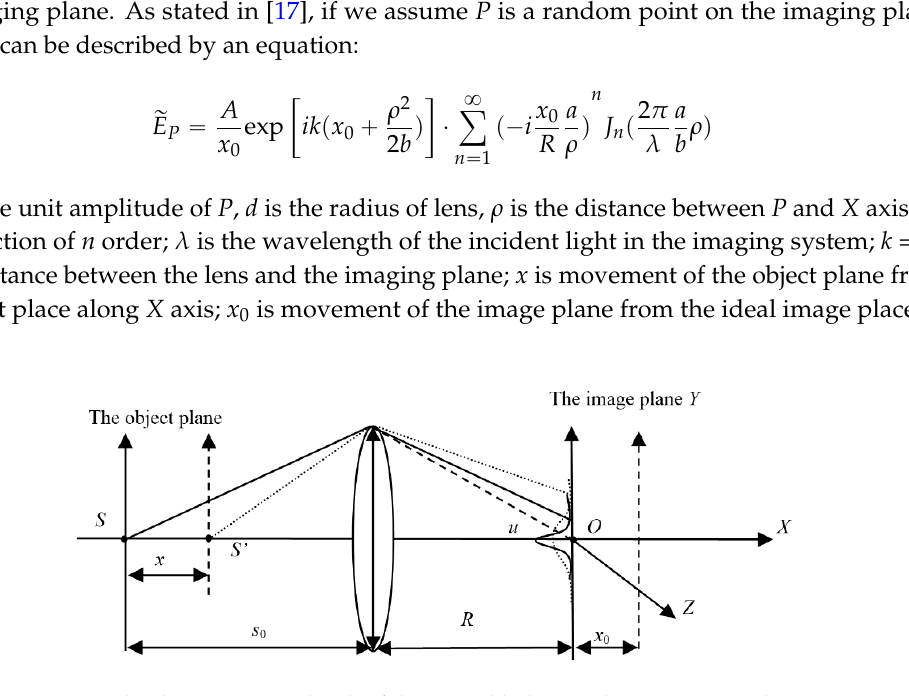
Figure 1. The diagrammatic sketch of the optical light traveling in an optical system.